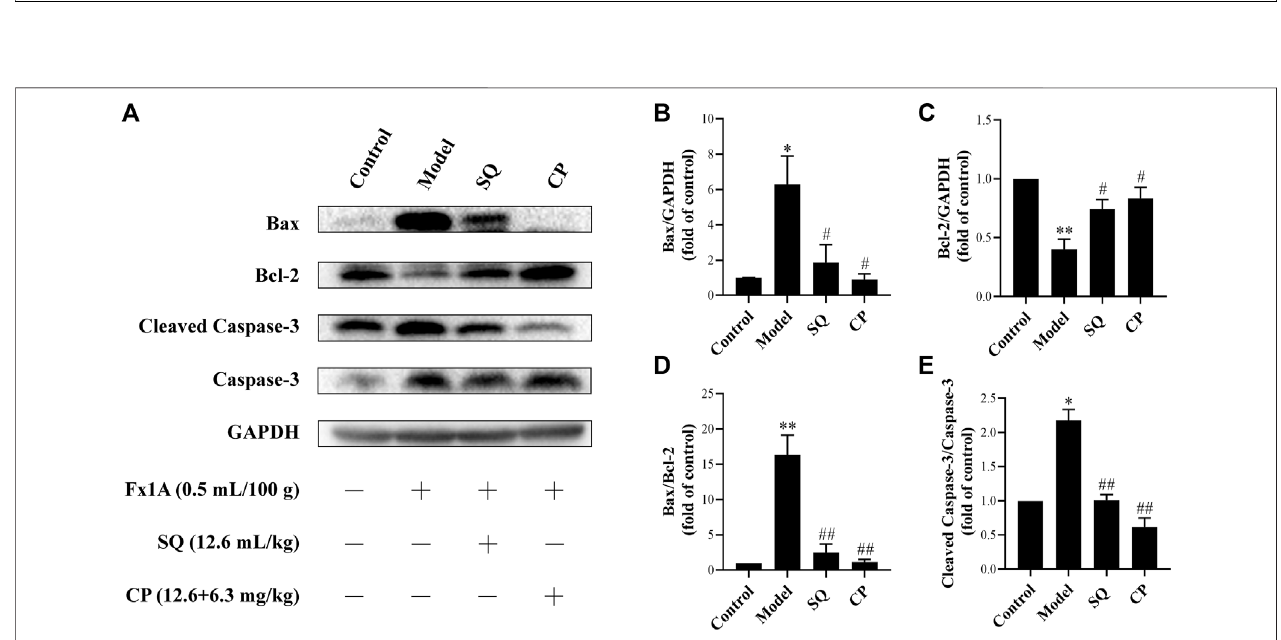
FIGURE 5 | SQ diminished the activation of the apoptosis pathway in glomeruli of PHN rats. Western blot was adopted to analyze apoptosis protein markers in kidney of rats in each group (A) , including Bax, Bcl-2, Cleaved Caspase-3, Caspase-3. Treatment with SQ and CP could suppress the protein levels of Bax (B) and Cleaved Caspase-3 (E) and elevate the expression of Bcl-2 (C) in kidney of PHN rats together with the Bax/Bcl-2 ratio (D) ( n (cid:1) 3). Data are represented as mean ± SD from independent groups. * p < 0.05 vs. control group. ** p < 0.01 vs. Control group. # p < 0.01 vs. Model group. ## p < 0.01 vs. Model group.